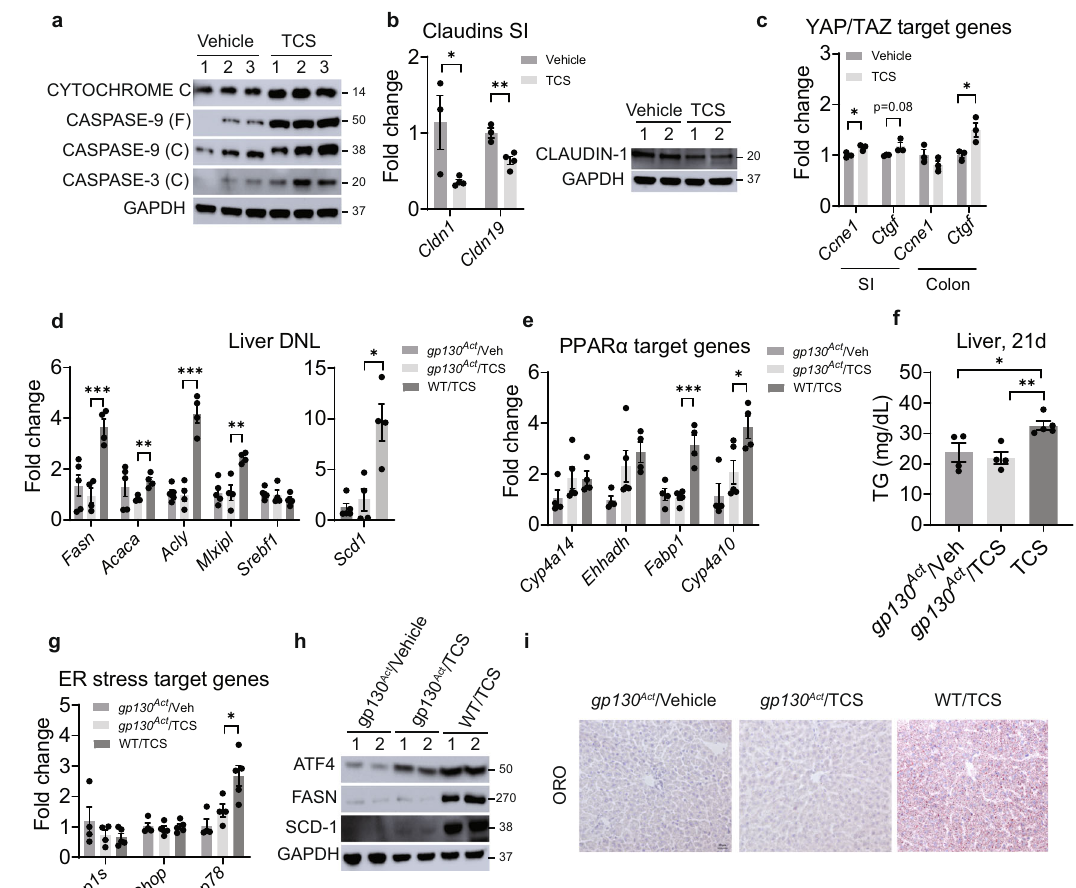
Fig. 8 | Activation ofgp130 suppresses liver DNL, PPAR α activityand ER stress in liver ofTCS breastfed mice. gp130 Act mice received normalmilkorTCSthrough lactation for 21 days. a IB analysis of cytochrome C, caspase 9, cleaved caspase-3 ( n =3 per group). b Expression of claudins and IB of claudin-1 in intestines (vehicle, n =3 per group and TCS, n =4 per group). c Expression of YAP/TAZ target genes in the intestines ( n =3 per group). d Expression of hepatic lipogenic genes ( gp130 Act /vehandWT, n =4micepergroupand gp130 Act /TCS, n =5). e Expressionof